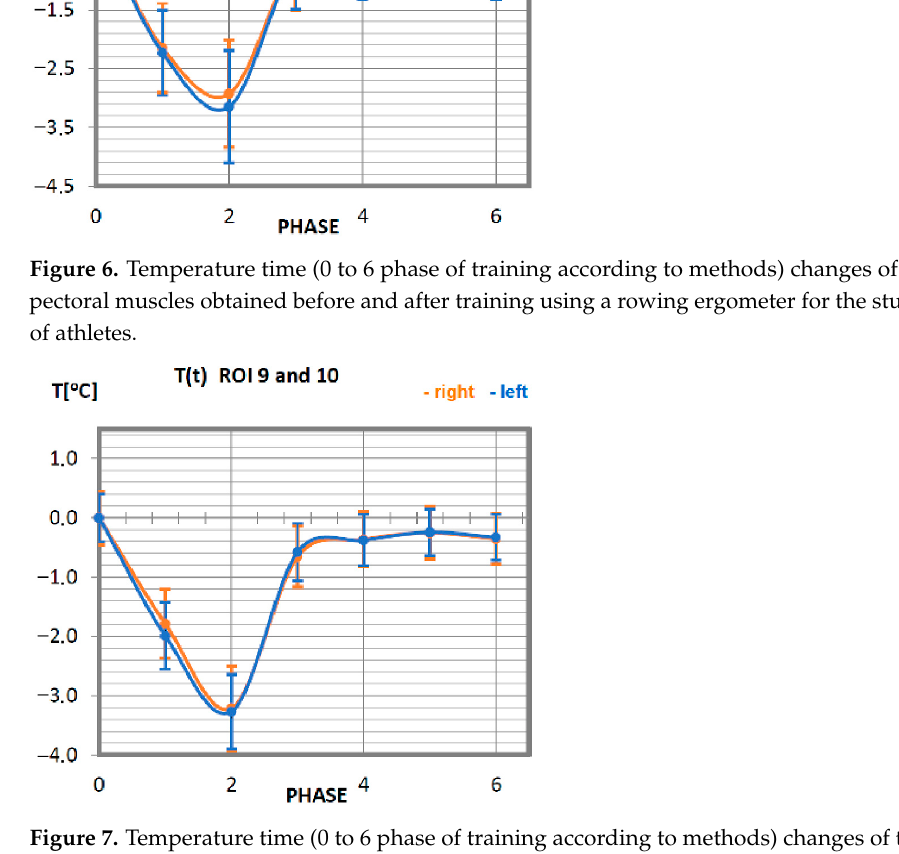
Figure 7. Temperature time (0 to 6 phase of training according to methods) changes of the anterior dentate muscle obtained before and after training using a rowing ergometer for the studied group of athletes.